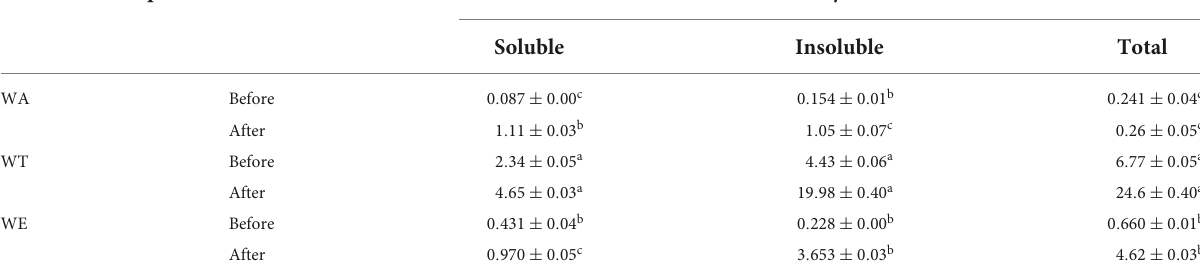
TABLE 1 Changes of dietary fiber content in each group before and after in vitro digestion (g/100 g). Samples